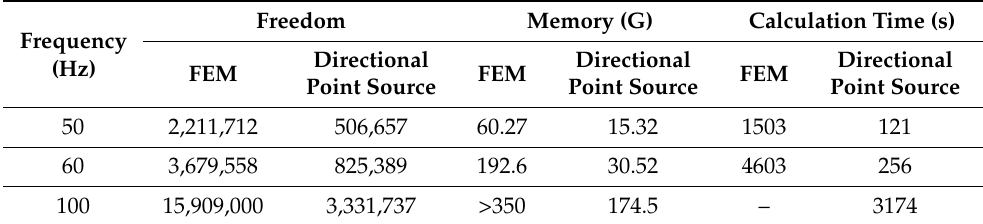
Table 1. FEM and directional point source calculation